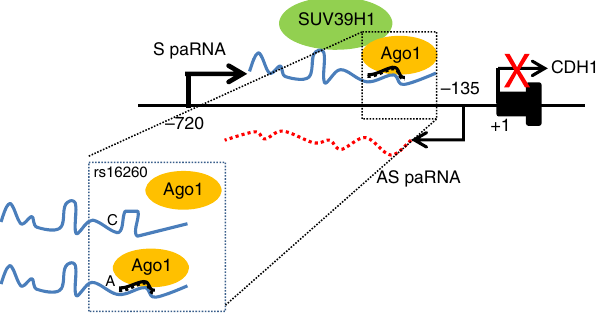
Figure 8 | Proposed model of the impact of SNP rs16260 on CDH1 promoter regulation. Assembly of the isomiR-4534/AGO1 complex on sense promoter-associated RNA silences CDH1 transcription. SNP rs16260 influences, through changes in the sense transcript secondary structure, the loading of isomiR-4534/AGO1 and the assembly of the transcriptional silencing